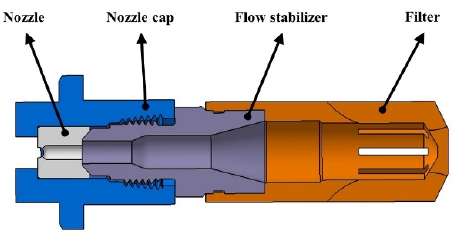
Figure 2. A structural diagram of the high-pressure water descaling nozzle.